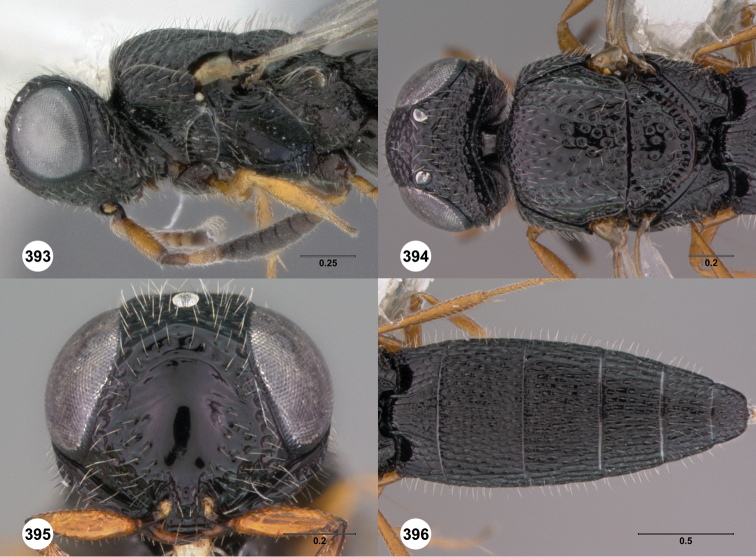
Oxyscelio velamenti sp. n., holotype female (OSUC 436034) 393 Head and mesosoma, lateral view 394 Head and mesosoma, dorsal view 395 Head, anterior view 396 Metasoma, dorsal view. Morphbank102